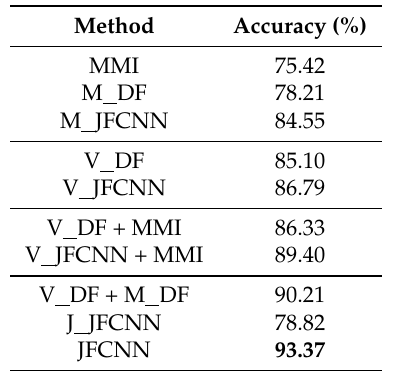
Table 3. Classification accuracies (%) of different